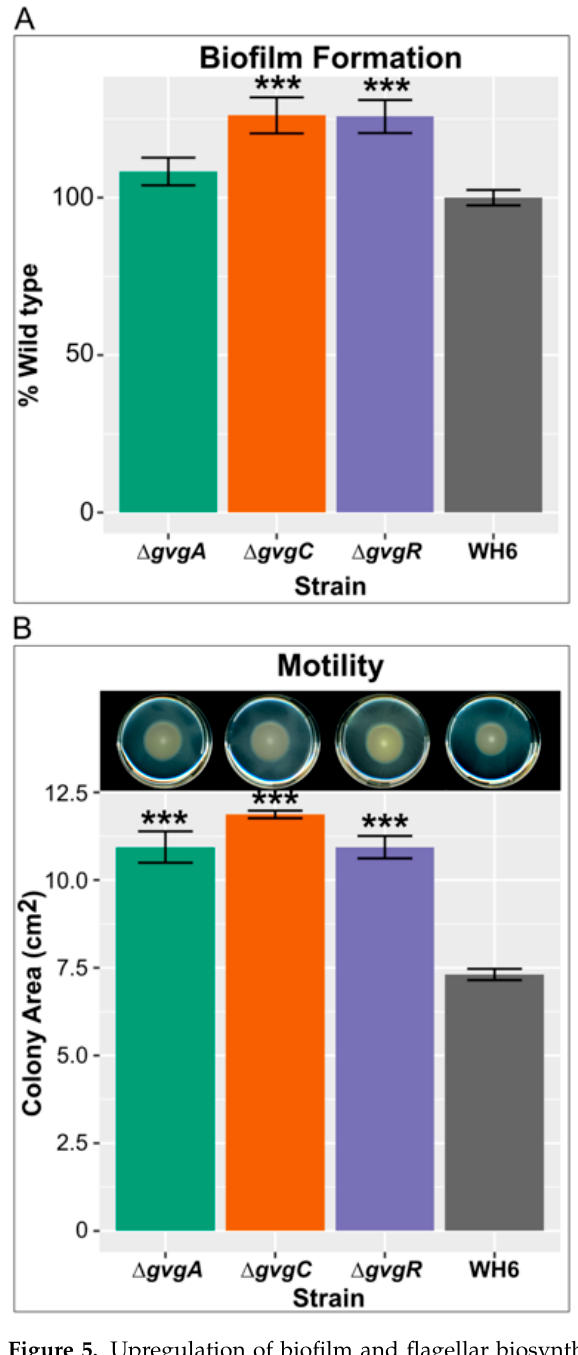
Figure 5. Upregulation of biofilm and flagellar biosynthesis pathways lead to increased biofilm formation and motility. ( A ) Biofilm formation as a percent of WT WH6. Bars represent the average of two independent experiments with four replicates each. ( B ) Swimming motility of Δ gvgA , C , and R and WT WH6. Top panel shows a representative swim plate 48 h after inoculation and the bottom panel bars represents the average area of growth after 48 h from three independent experiments with three replicates each. Error bars = standard error. *** = p ≤ 0.001 by Student’s t-Test.